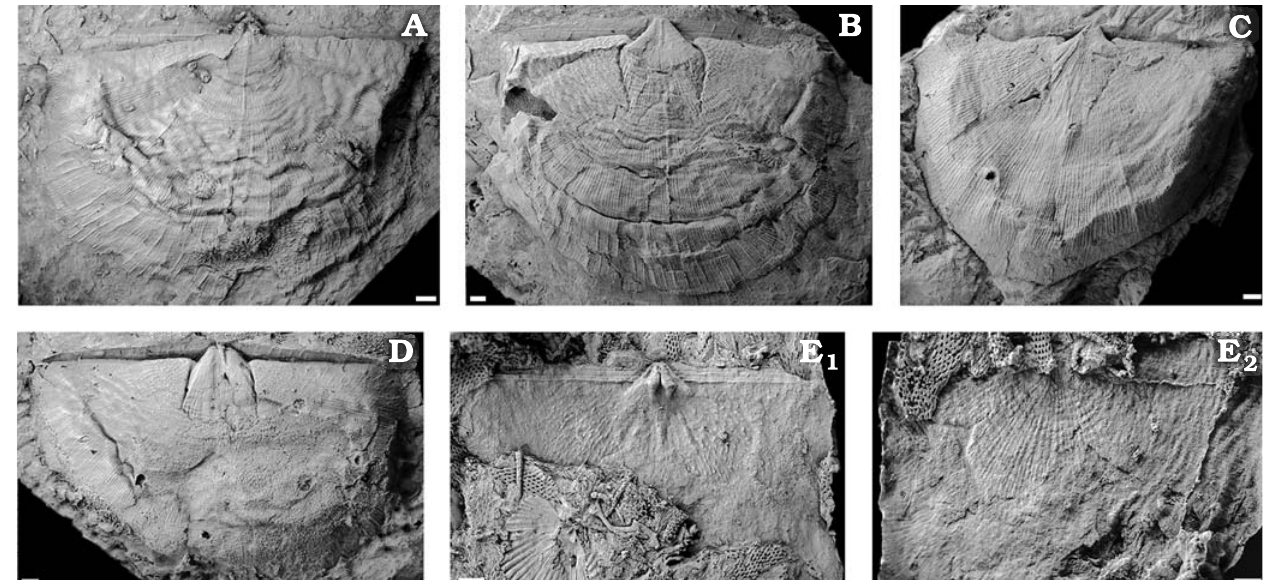
Fig. 4. Valves of rafinesquinine brachiopod Kjaerina ( Kjaerina ) sp. A.; upper Katian (Ka3–4), Upper Ordovician; Fombuena Formation at Alpartir (A, B, D) and Luesma (C, E), Iberian Chains, Spain. A . MPZ 2015/1346, latex cast of exterior of a complete and flattened ventral valve, showing the cardinal process lobes of the dorsal valve protruding in the vicinity of the hinge line. B . DPZ 368, internal mould of ventral valve. C . MPZ 2015/1347, internal mould of ventral valve, showing the convergent anteriorly muscle bounding ridges. D . DPZ 369, internal mould of ventral valve. E . DPZ 372, latex cast of interior (E 1 ) and exterior (E 2 ) of an incomplete dorsal valve. Scale bars 2 mm.